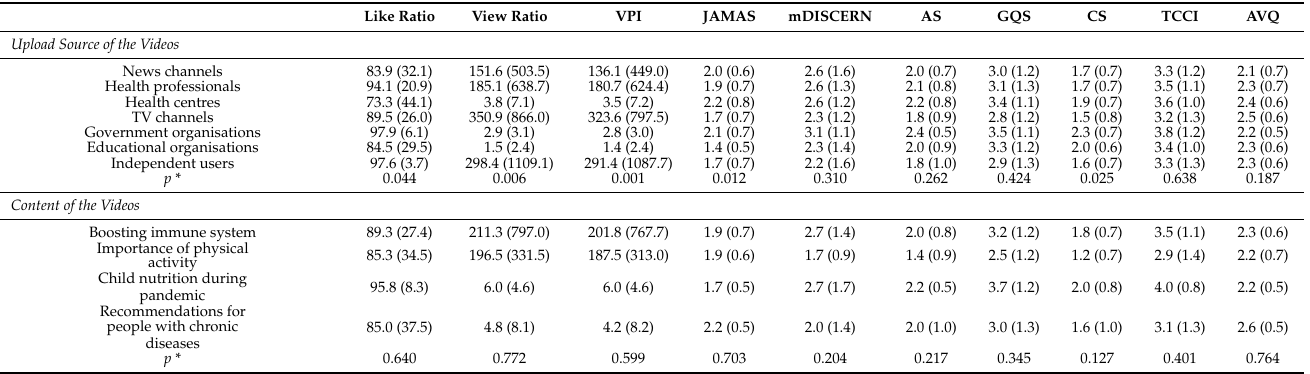
Table 3. Mean like ratio, view ratio, VPI, AVQ, accuracy score, CS, GQS, CCI, RA, and JAMAS values of the videos based on source and content.